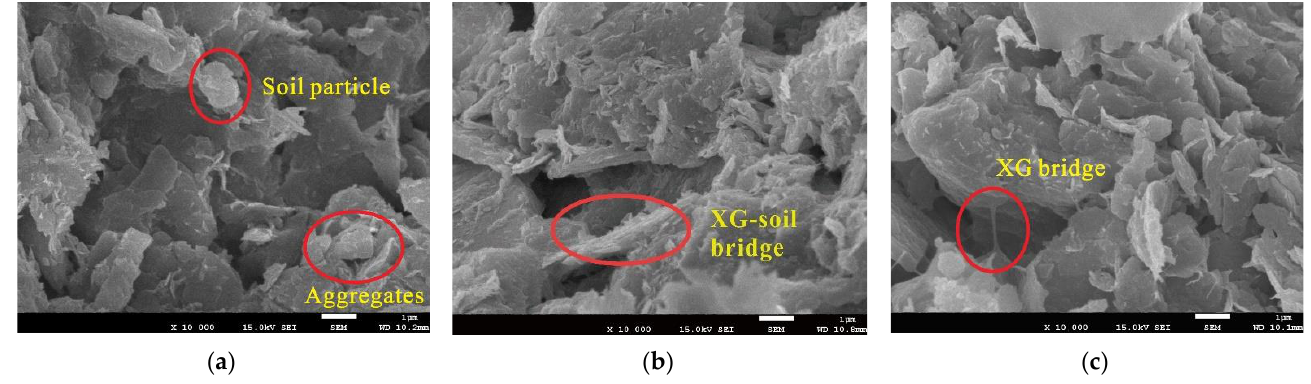
Figure 11. SEM pictures of XG-silt at ×10000 magnification: ( a ) m bp / m s = 0%; ( b ) m bp / m s = 1.0%; ( c ) m bp / m s = 2.0%.